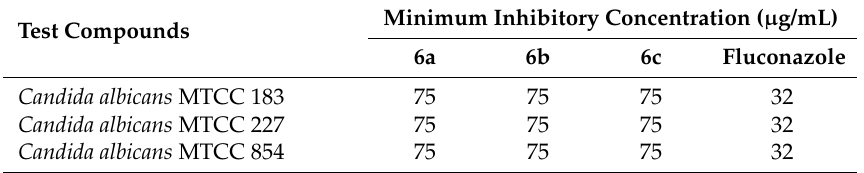
Table 3. Antifungal activity of zinc complexes of modified polyacrylic acid 6a , 6b and 6c . Test